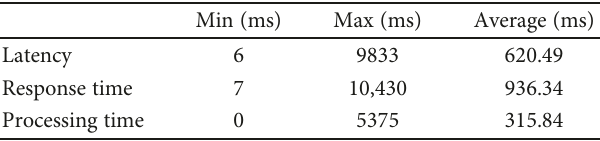
Figure 9: Geographical measurements of the emulation mode with hop (response